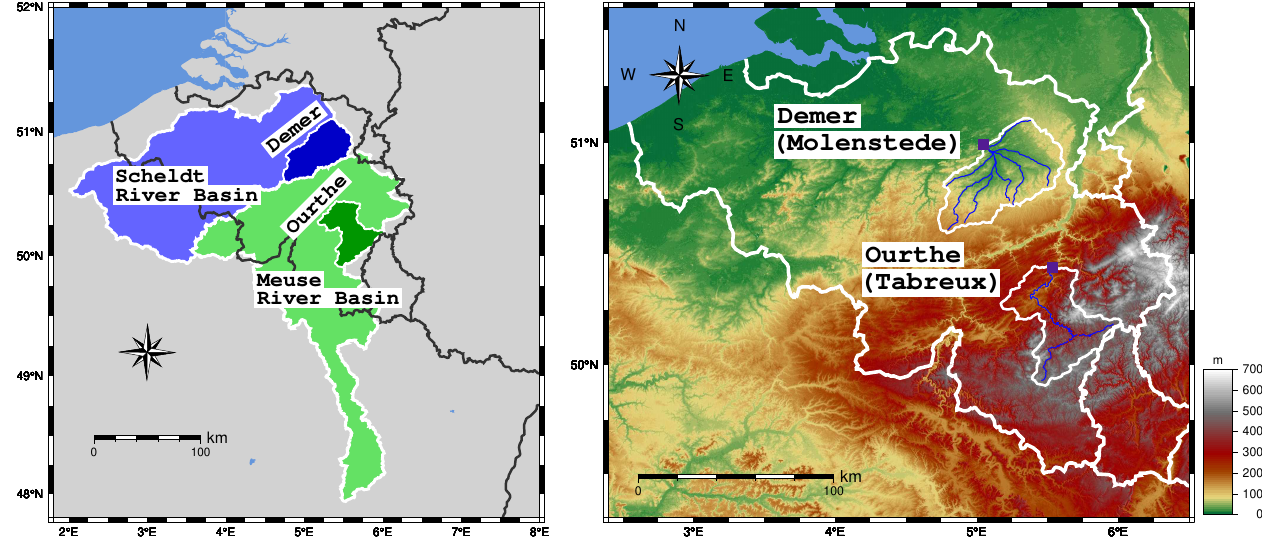
Figure 1. Left: the river basins (Scheldt and Meuse, in light colors) and the catchments (Demer and Ourthe, in dark colors) included in the present study. Right: the Demer and Ourthe catchments with topographic features and their outlets. The elevation data are based on